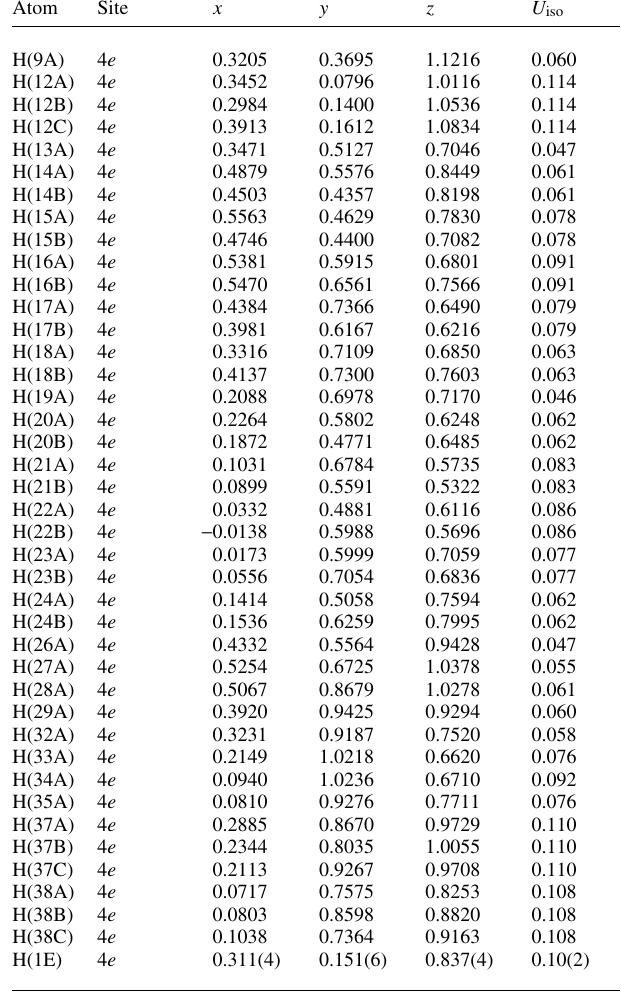
Table 3. Atomic coordinates and displacement parameters (in Å 2 ) .